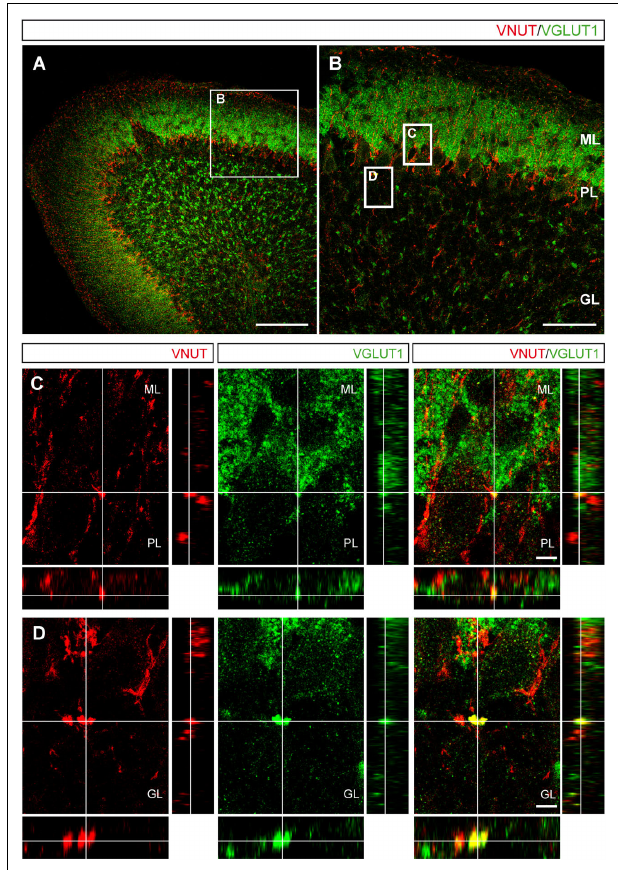
FIGURE 6 | Localization of VNUT and VGLUT1 in the mouse cerebellar cortex. (A) Representative micrograph of a section of the P15 cerebellum immunostained for VNUT (red) and VGLUT1 (green). Scale bar: 100 µ m. (B) Higher magnification of the selected region in (A) showing the three cerebellar layers. Scale bar: 50 µ m. The insets are shown in the lower panels. (C,D) Orthogonal sections. Selected z-scanning series of images showing double labeling for VNUT and VGLUT1, representing the three planes of view for one point, as indicated by the crossed dashed lines. Scale bar: 10 µ m. ML, Molecular Layer; PL, Purkinje Layer; GL, Granular